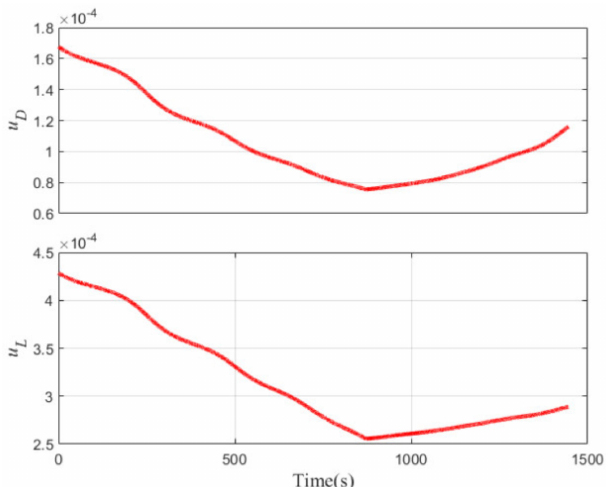
Figure 5. Quasi-ballistic coefficients versus time.